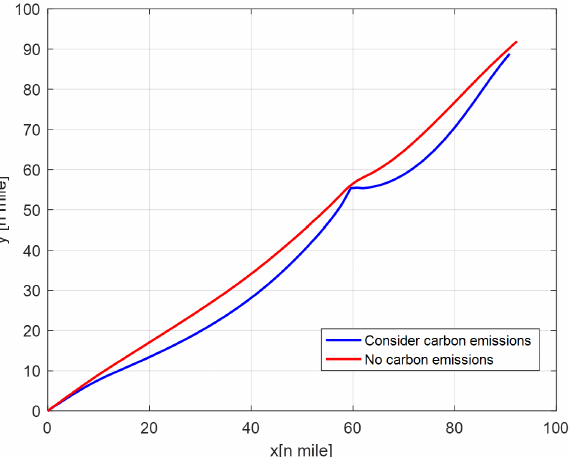
Figure 8. Path with carbon emissions added and no carbon